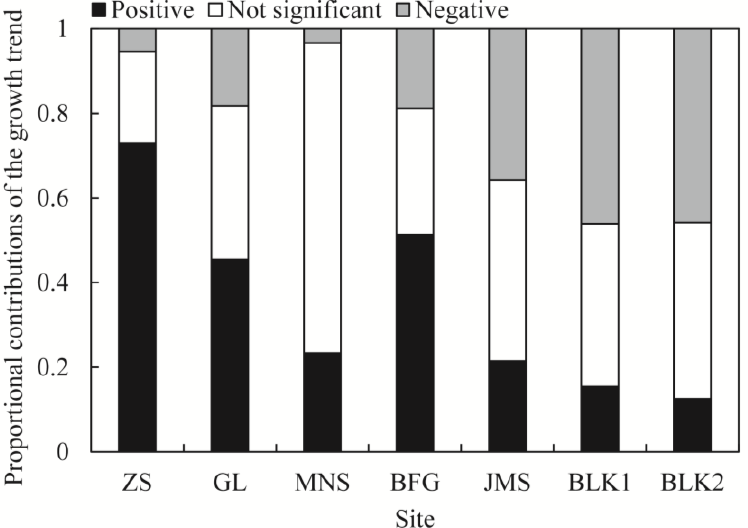
Figure 5. Proportion of trees with a significantly positive, significantly negative and not significant growth trend at seven